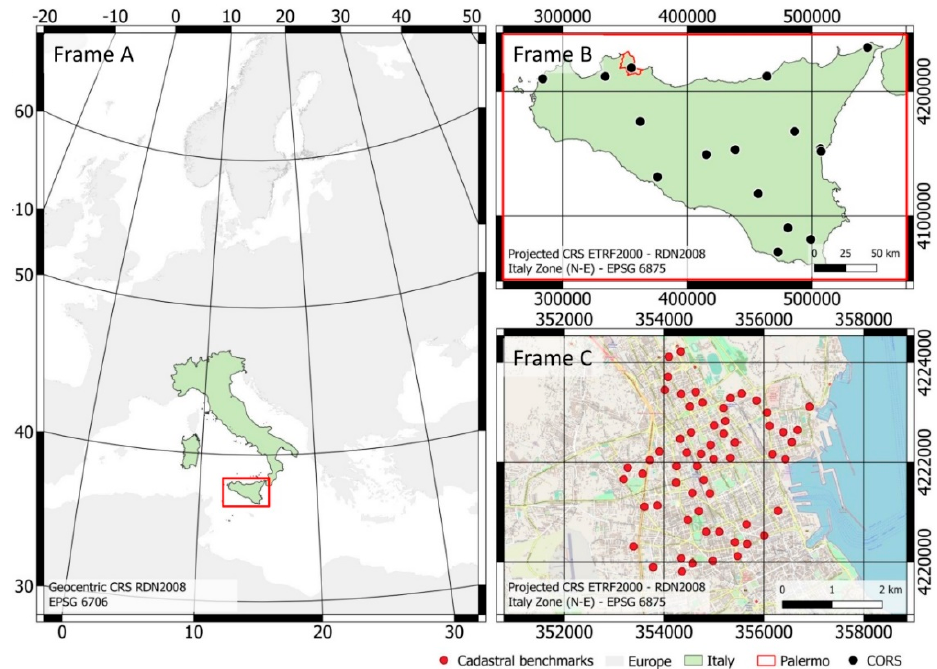
Figure 2. The location of Sicily (red rectangle, Frame A) within the Italian territory (light green, Geocentric CRS RDN2008-EPSG: 6706). CORS permanent stations in Sicily (Frame B, black dots, Projected CRS ETRF2000-RDN2008 UTM zone 33N-EPSG: 6708) overimposed the delimitation of the municipality of Palermo (red line). Cadastral marks in Palermo (red dots, Frame C, EPSG: